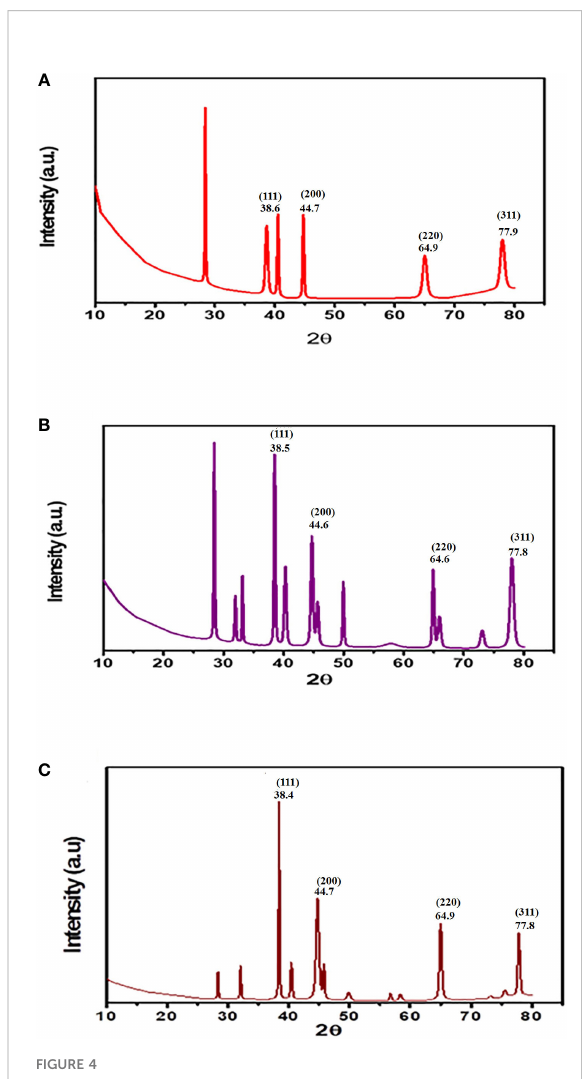
FIGURE 4 XRD pattern of Au-NPs biosynthesized using the ethanolic extracts of macroalgae (A) C. myrica (B) C. trinodis , and (C) C. prolifera